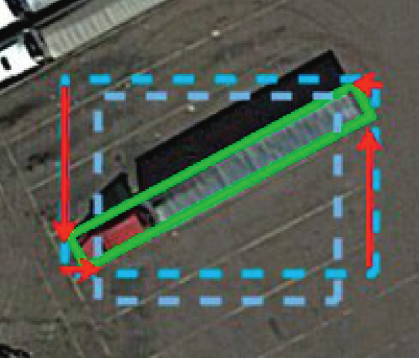
Figure 3: Cascading boundary regression